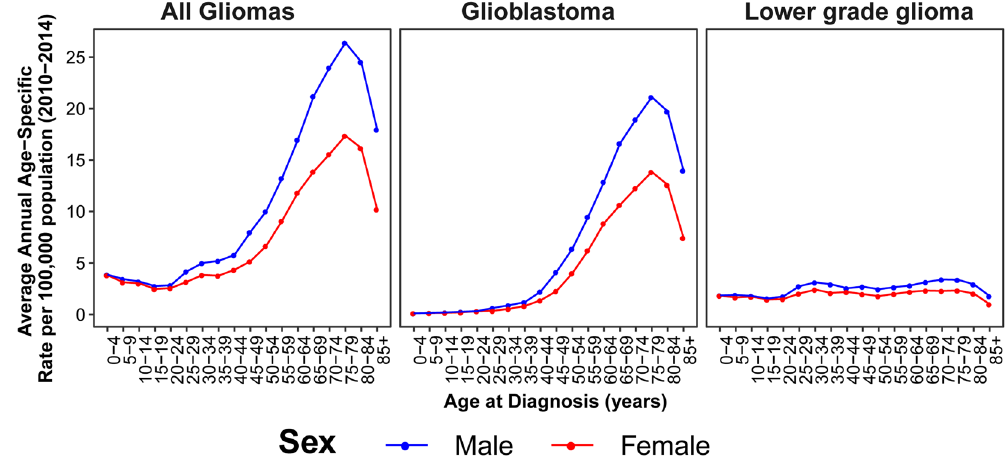
Figure 1. Average Annual Incidence of all glioma, glioblastoma and lower grade glioma by sex and age at diagnosis (CBTRUS